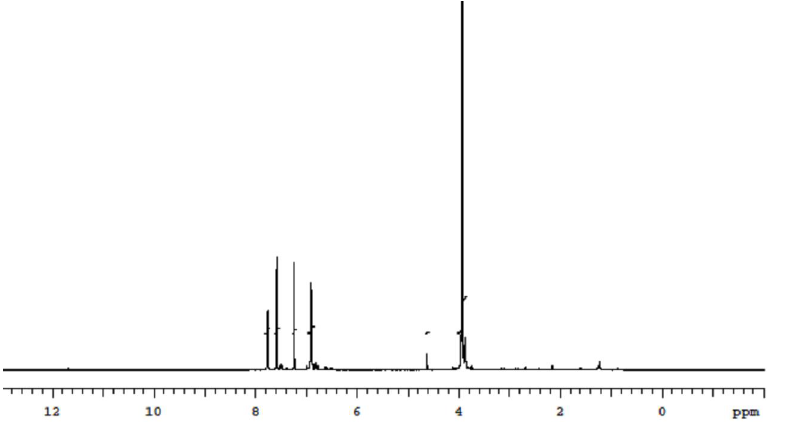
Figure 8. 1 H-NMR spectrum of 2',6'-dihydroxy-3,4-dimethoxy